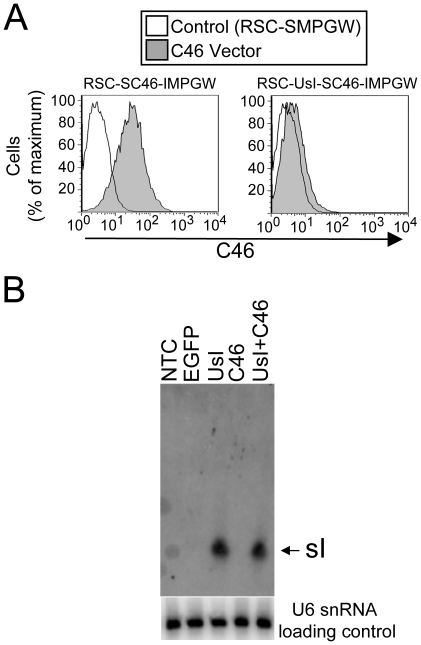
Effect of multiple components on expression of individual anti-HIV transgenes.(A) Expression of the membrane-bound C46 fusion inhibitor was detected by antibody staining in transduced MAGI-CCR-5 cells. Cells transduced with either a control vector RSC-SMPGW that does not express C46, or the C46 vector RSC-SC46-IMPGW, or the U6-driven site I shRNA and C46 vector RSC-UsI-SC46-IMPGW were sorted to over 98% EGFP-positive cells and stained using a primary C46 monoclonal and a secondary phycoerythrin-conjugated antibody. Expression of the C46 transgene is greatly reduced in cells transduced with the vector that also expresses the U6-driven site I tat/rev shRNA. (B) Expression of the U6-driven site I tat/rev shRNA was compared by Northern blot in MAGI-CCR-5 cells using a tat/rev site I-specific probe (top panel). NTC is non-transduced control, EGFP is cells transduced with a lentiviral vector that only expressed EGFP, UsI is cells transduced with a vector that expresses EGFP and the U6-driven site I shRNA, C46 is the vector RSC-SC46-IMPGW, UsI+C46 is the vector RSC-UsI-SC46-IMPGW. The arrow indicates approximately 21 nt. Expression of the U6-driven site I tat/rev shRNA was not affected by the addition of a C46 transgene. The bottom panel is a loading control with a U6 snRNA probe hybridized to the same blot.